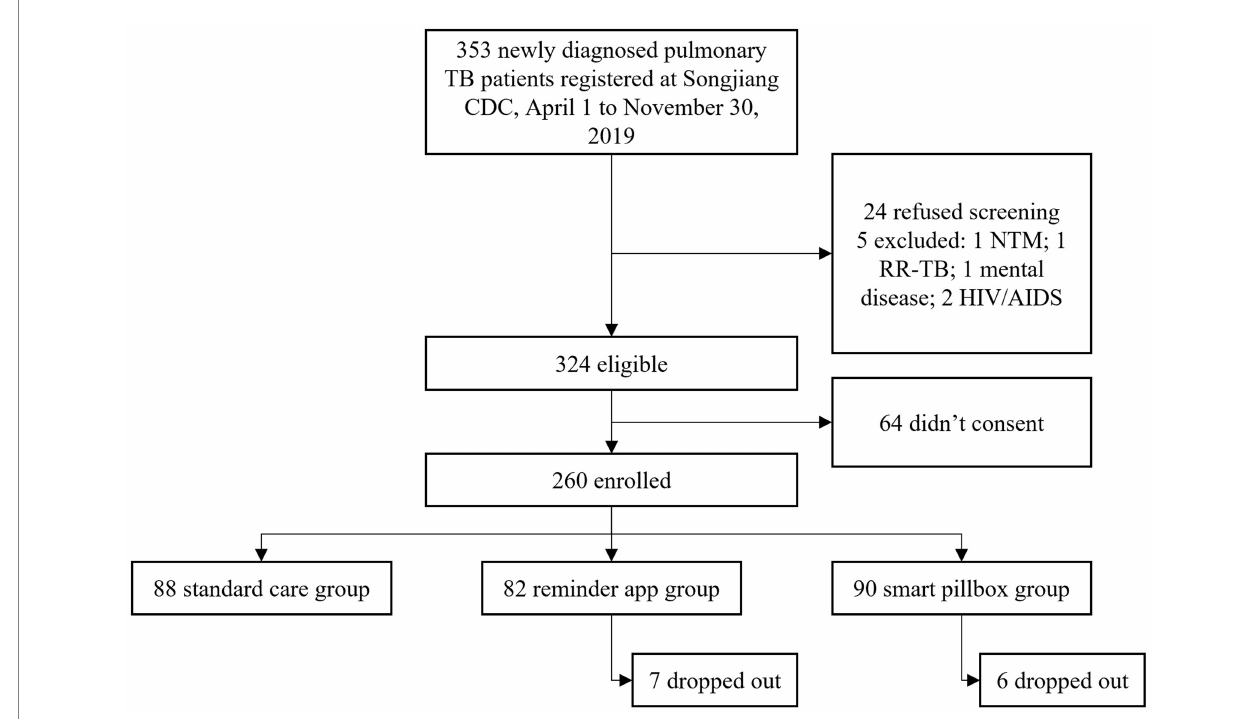
FIGURE 2 Flow chart. TB, tuberculosis; CDC, Center for Diseases Control and Prevention; NTM, nontuberculous mycobacterial disease; RR-TB, rifampicin- resistant